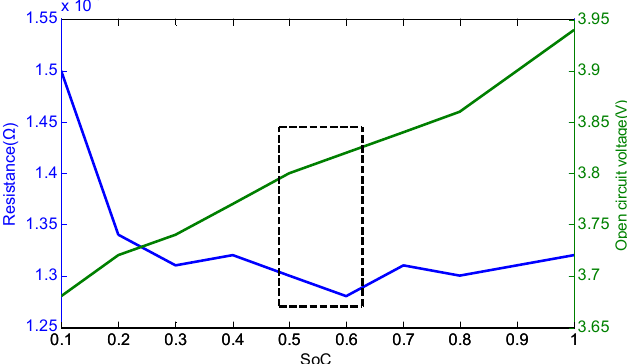
Figure 6. The battery resistance and open circuit voltage.